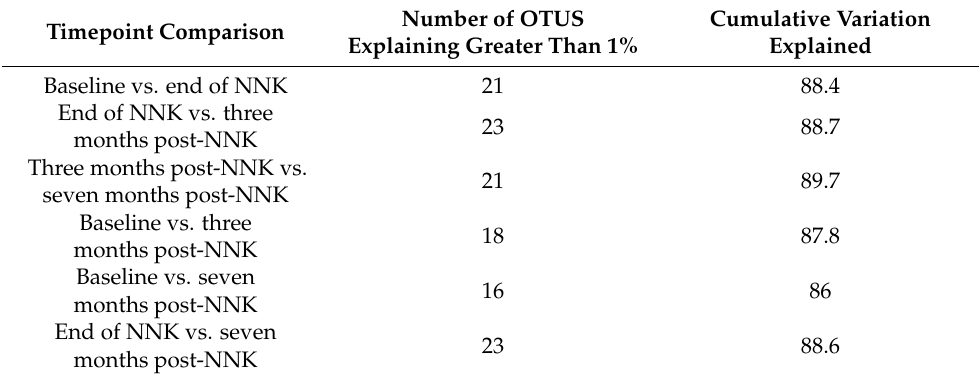
Table 3. Gprc5a − / − ; Lcn2 − / − gut microbiome SIMPER analysis.